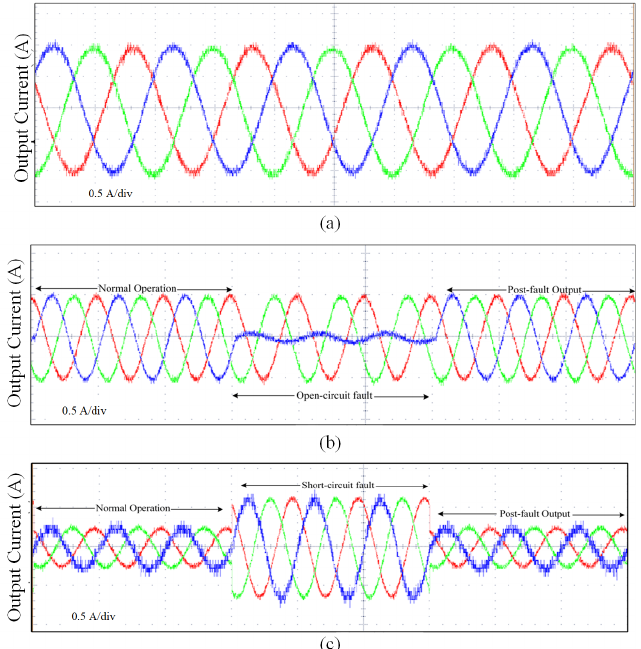
Figure 11. Experimental results: ( a ) Normal operation, ( b ) open-circuit fault, and ( c ) short-circuit